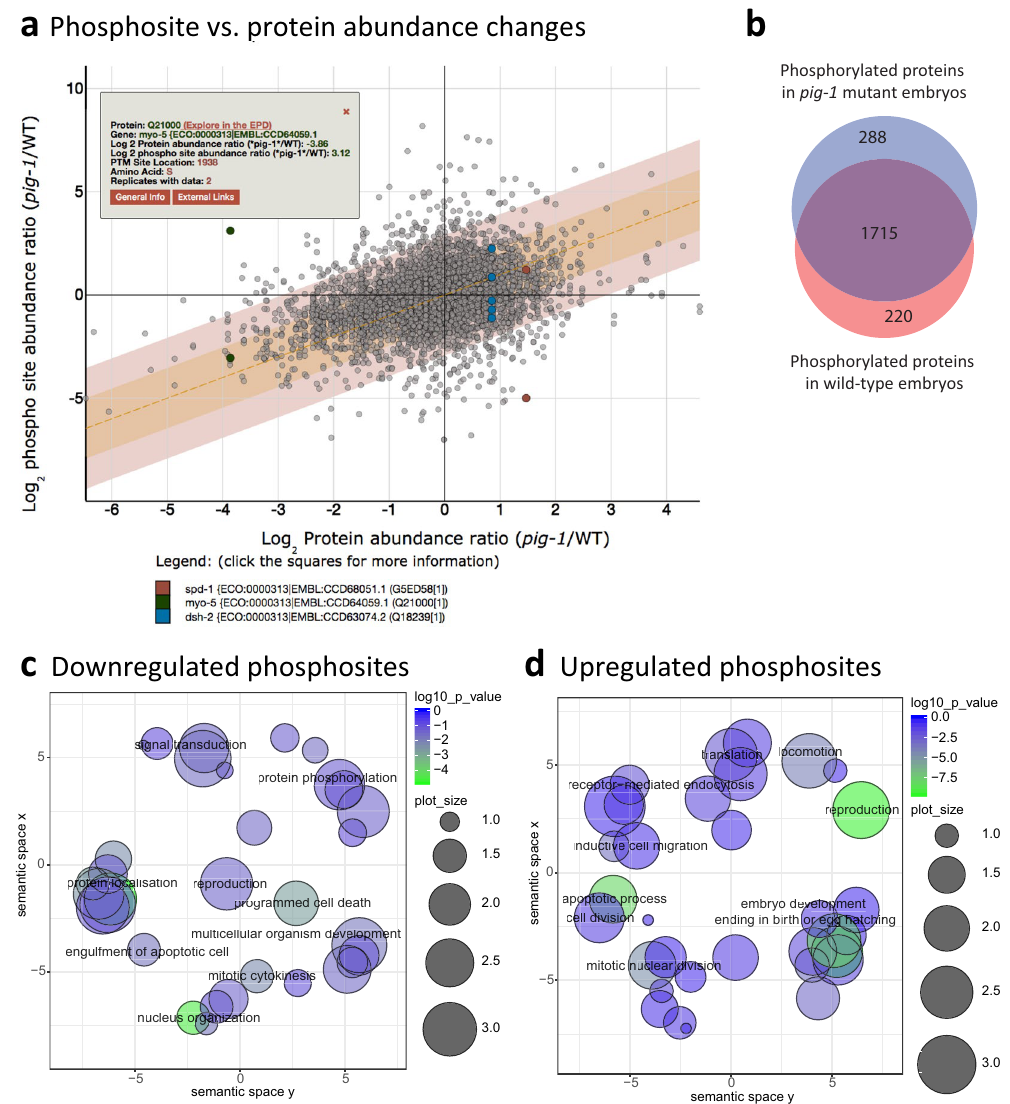
Figure 7. Global phosphoproteome changes in pig - 1 mutant embryos. ( a ) Phosphorylation site abundance ratio ( pig - 1 /wild-type) compared to protein abundance ratio ( pig - 1 /wild-type). The orange dotted line indicates where the phosphorylation site ratio is equal to the protein ratio. Points within the orange and red areas are within one and two standard deviations from equality, respectively. An interactive version of this plot is accessible online via the EPD. In this illustration, detected phosphorylation sites for three example proteins were marked and a tooltip containing further information is shown for one of these phosphorylation sites. ( b ) Number of phosphorylated proteins detected either in wild-type (red) or in pig - 1 mutant embryos (blue) or in both genetic backgrounds (purple overlap)(localisation probability > 75%). ( c and d ) Gene ontology (GO) term enrichment (biological process) of pig - 1 variant phosphosites. x- and y-axis indicate semantic space used to group GO terms of related biological processes. Bubble sizes indicate the frequency of the GO term in the underlying C . elegans protein database (larger bubbles reflect more common terms) and bubble colour indicates statistical significance (the greener, the lower the p-value). ( c ) GO term analysis of downregulated phosphosites in the pig - 1 mutant (related to Supplementary Table 5c). Phosphosites downregulated in pig - 1 (outside of the 2 standard deviation range in ( a )) were pooled with phosphosites that were only detected in wild-type embryos (red in ( b )). ( d ) GO term analysis of phosphosites with upregulated abundance in the pig - 1 mutant (Supplementary Table 5d). Phosphosites upregulated in pig - 1 mutant embryos (outside of the 2 standard deviation range in ( a )) were pooled with the phosphosites that were only detected in pig - 1 mutant embryos (blue in b